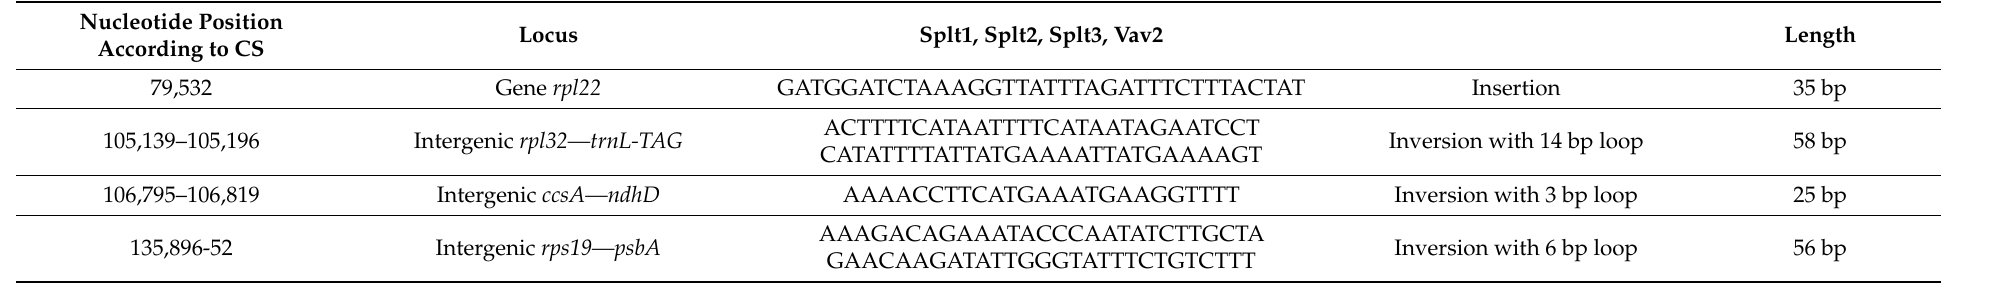
Table 6. Inversions and a long insertion specific for chloroplast DNA of hexaploid